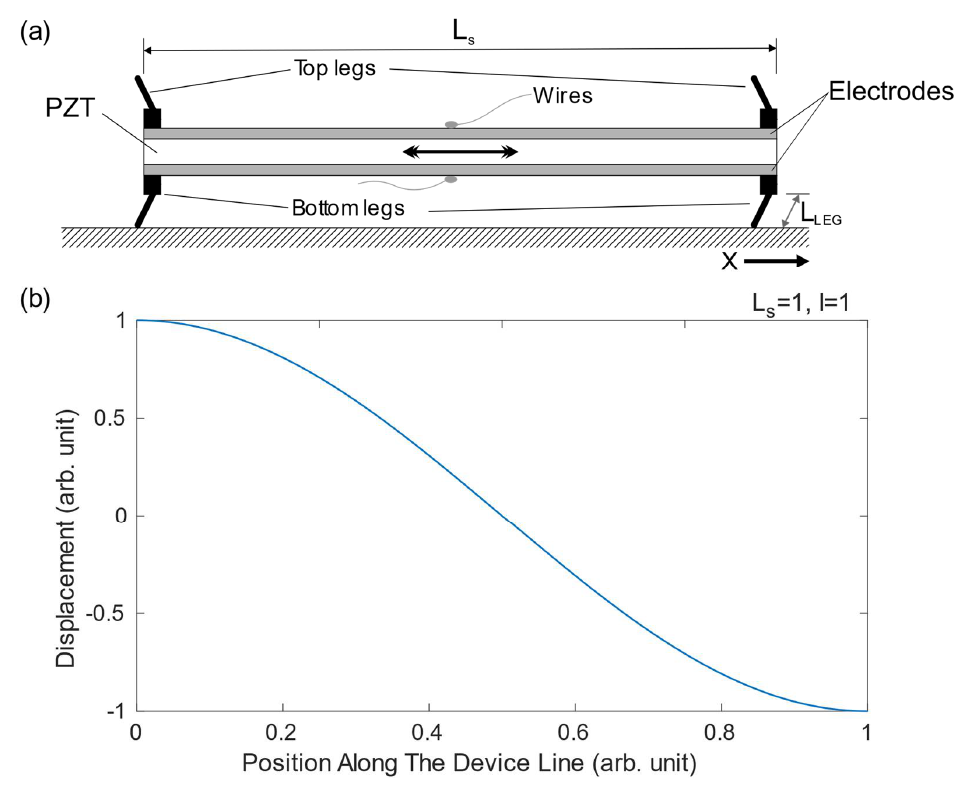
Figure 2. ( a ) Schematic of the locomotion system under study. ( b ) Normalized displacement in the X-axis for the first extensional mode.